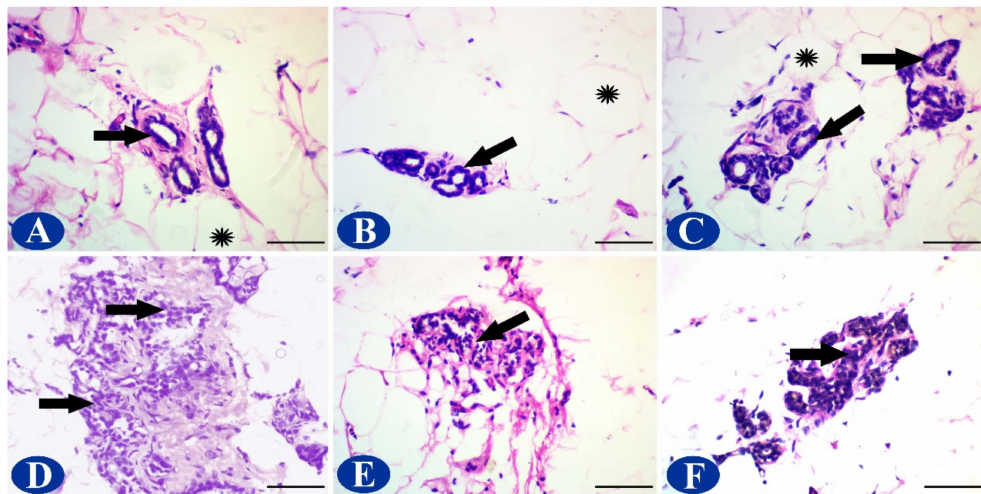
Figure 4. Results of histopathological assessment. ( A ) Negative control group shows the normal structure of the acini (arrow) with adipose tissue inbetween (*). ( B ) 7b group showing normal acini (arrow) and adipocytes (*). ( C ) The 15b group showed normal lobules (arrow) and adipose tissue (*). ( D ) Breast tissue from the DMBA group showed extensive proliferation of cancer cells (arrows). ( E ) Adult female rats administered DMBA and treated with 7b showed marked regression of tumor mass (arrow). ( F ) breast tissue of DMBA-treated rats with 15b revealed moderate regression of tumor mass (arrow). H & E. Scale bar = 50 µ m.